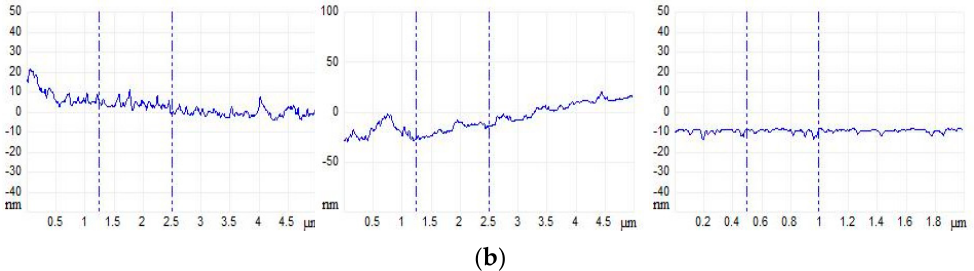
Figure 3. ( a ) Atomic force microscopy of sectioned GO plates ( b ) sectional thickness of each plate according to its height.